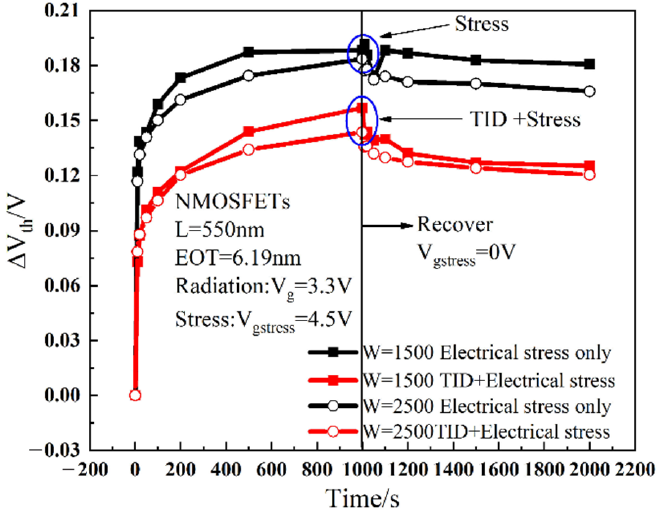
Figure 10. The relationship between threshold voltage shift with different gate widths as a function of time.